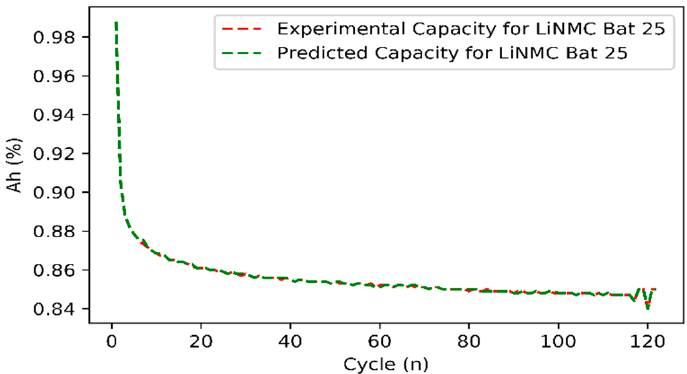
Figure 3. The capacity prediction of battery 25.